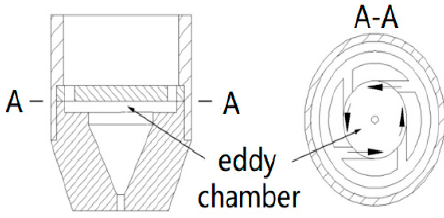
Figure 1. Tangential injection swirl nozzle (A is cross section symbols for location).